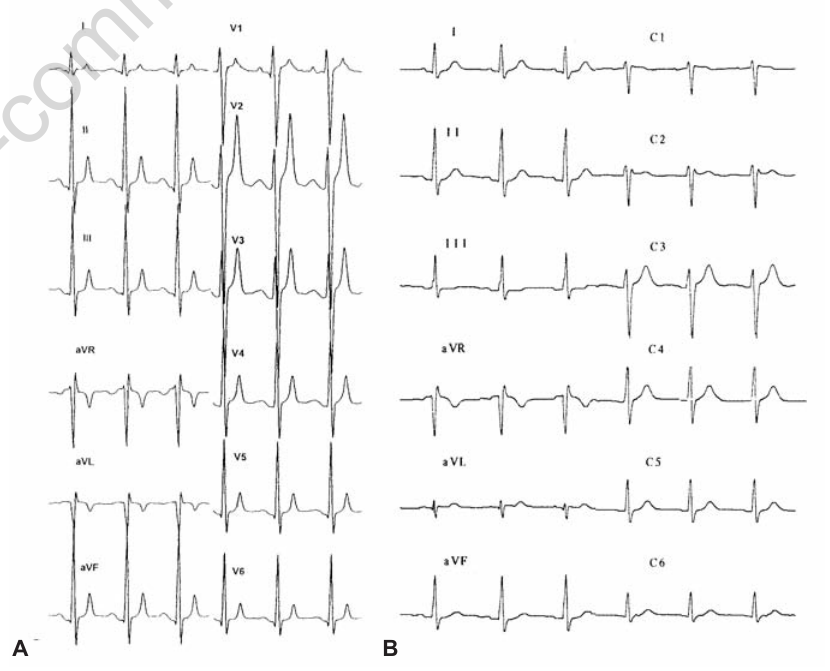
Figure 3. p.T618I-KCNH2 (SQTS1). Male, 15 years old. A) Basal electrocardiogram (ECG): QT 250 ms, QTc 337 ms, QT/QTp 80%. B) ECG recorded following